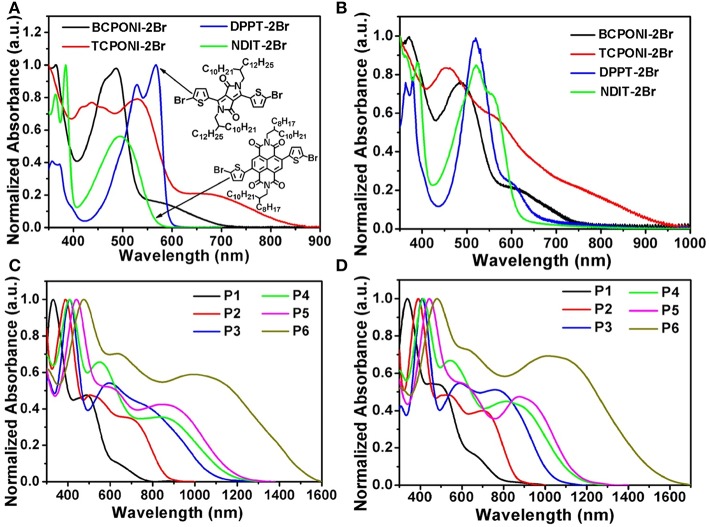
Absorption spectra of the monomers (BCPONI-2Br and TCPONI-2Br), their analogs (DPPT-2Br and NDIT-2Br), and as-synthesized polymers that measured in chloroform solution (A,C) and in thin film (B,D).